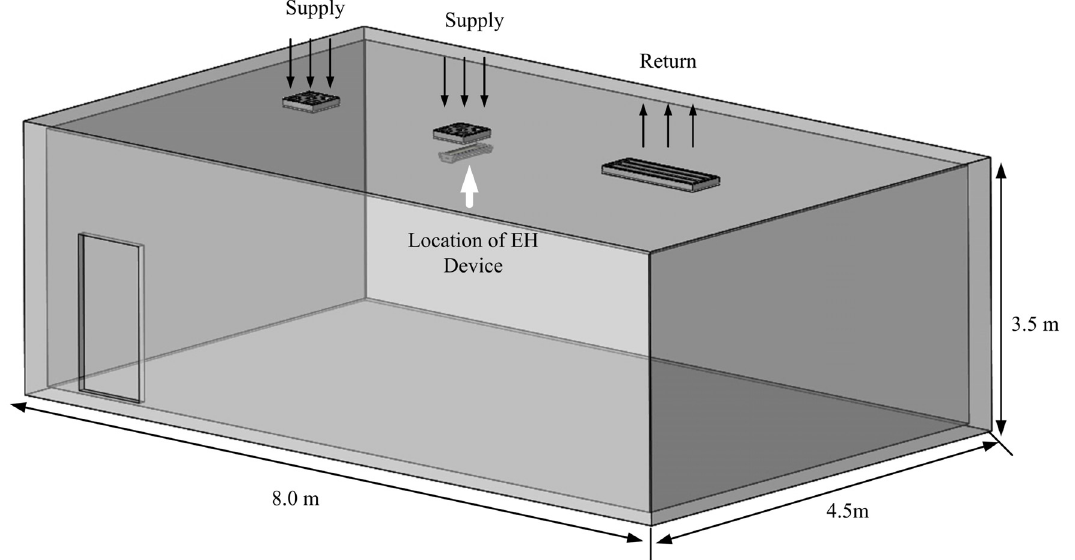
Figure 1. Geometry of the indoor airflow energy harvesting experiment laboratory, which